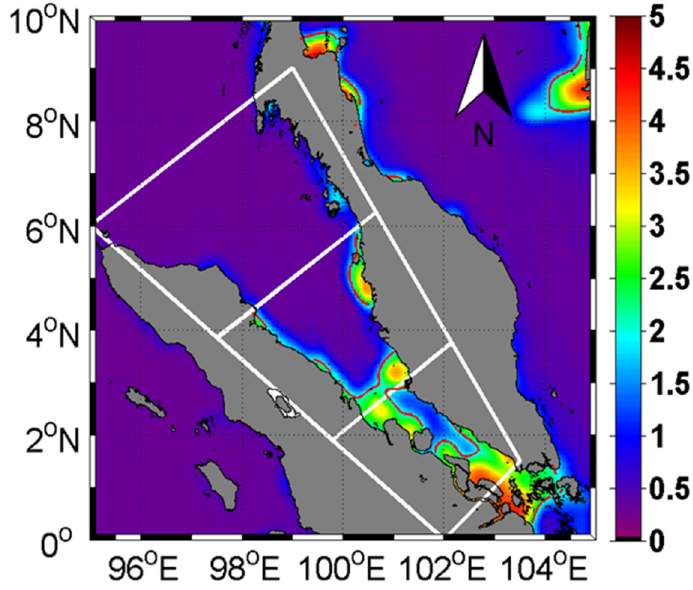
Figure 13. SeaWiFS full mission mean of normalized water-leaving radiance at 555 nm (nLw 555 ) (mW∙cm −2 ∙µm −1 ∙sr −1 ) in the SM. The red contour indicates nLw 555 = 1 mW∙cm −2 ∙µm −1 ∙sr −1 , which approximately separates turbid (areas with nLw 555 > 1 mW∙cm −2 ∙µm −1 ∙sr −1 ) from non-turbid (area with nLw 555 < 1 mW∙cm −2 ∙µm −1 ∙sr −1 )